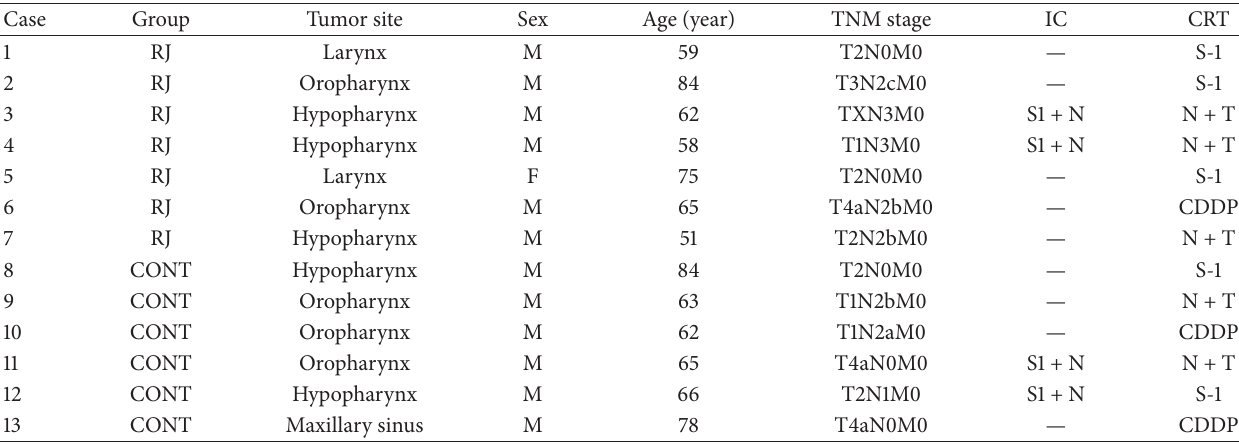
Table 1: Patients’ profile.